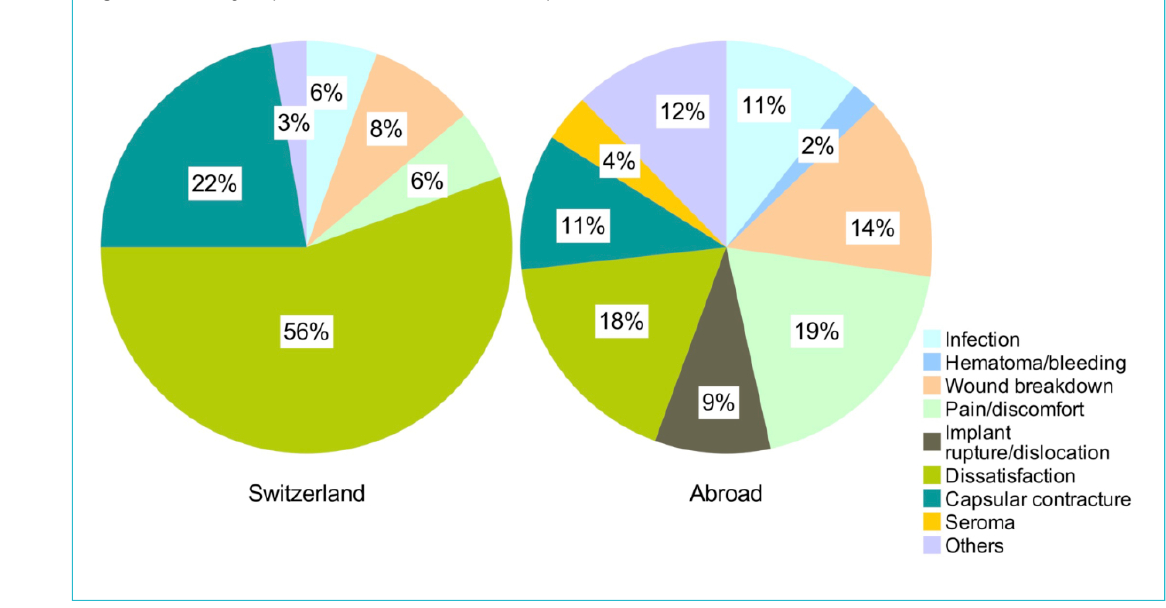
Figure 4: Percentage of presented domestic and abroad